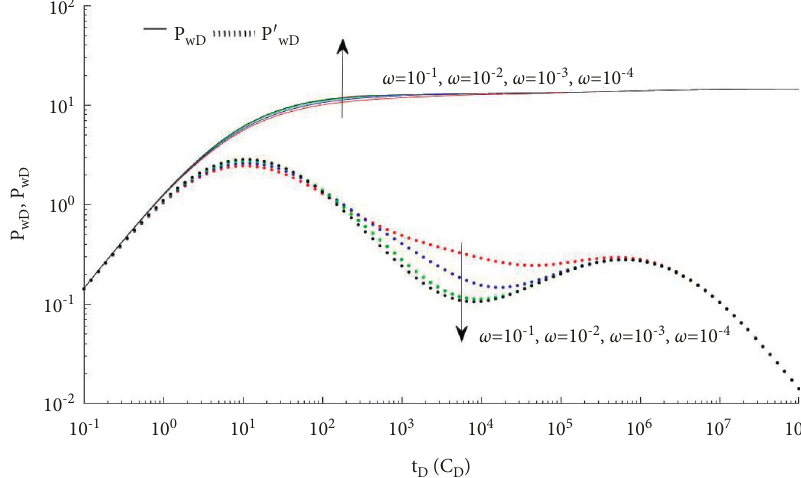
Figure 4: .Dimensionless pressure of vertical wells under the constant outer boundary influenced by ω ( C